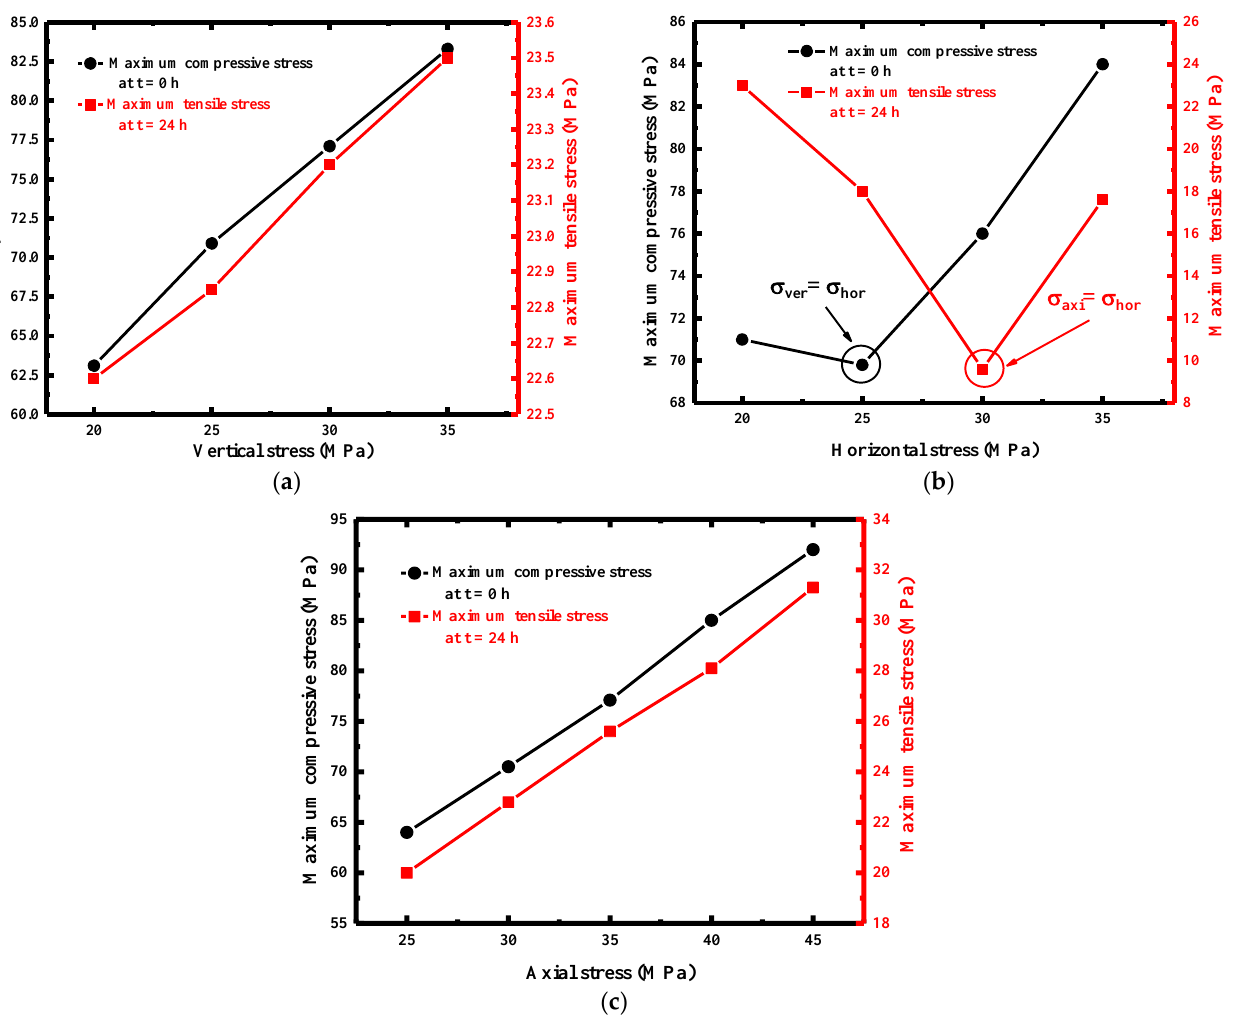
Figure 13. ( a ) Maximum compressive stress at t = 0 h and minimum stress at t = 24 h under different vertical stresses. ( b ) Maximum compressive stress at t = 0 h and minimum stress at t = 24 h under different horizontal stresses. ( c ) Maximum compressive stress at t = 0 h and minimum stress at t = 24 h under different axial